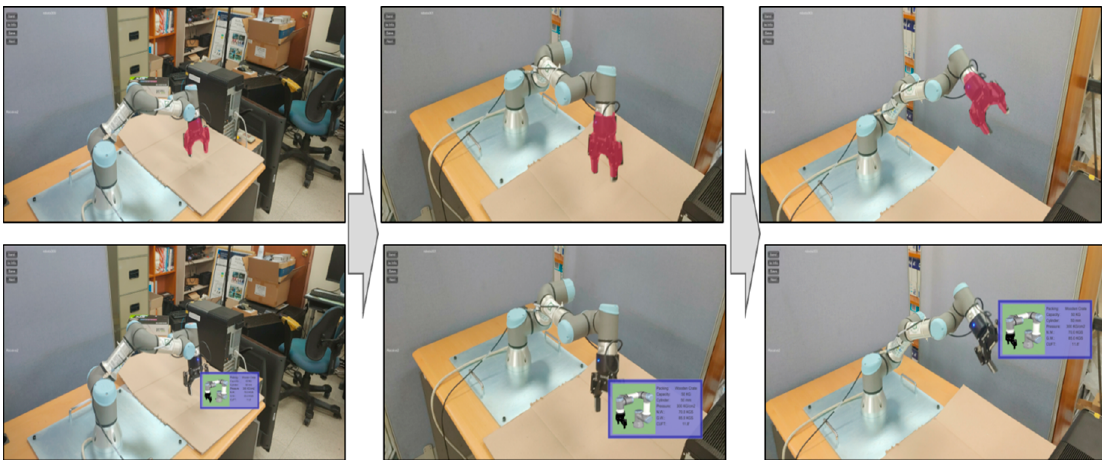
Figure 10. Adaptive visualization for a dynamically moving robot in industrial AR; the gripper of UR3 can also be detected, segmented, and annotated consistently.